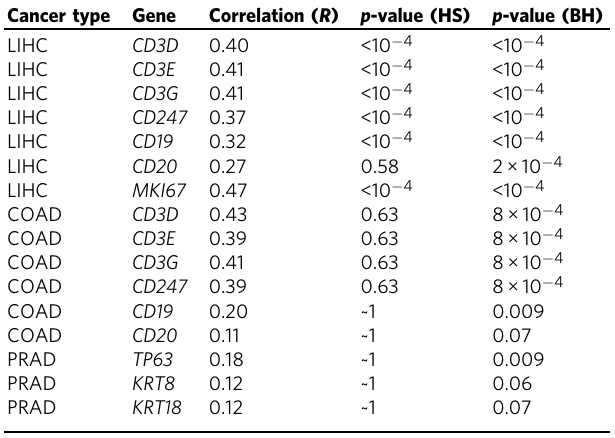
Table 1 Performance metrics for the prediction of genes of interest for virtual spatialization. Cancer type